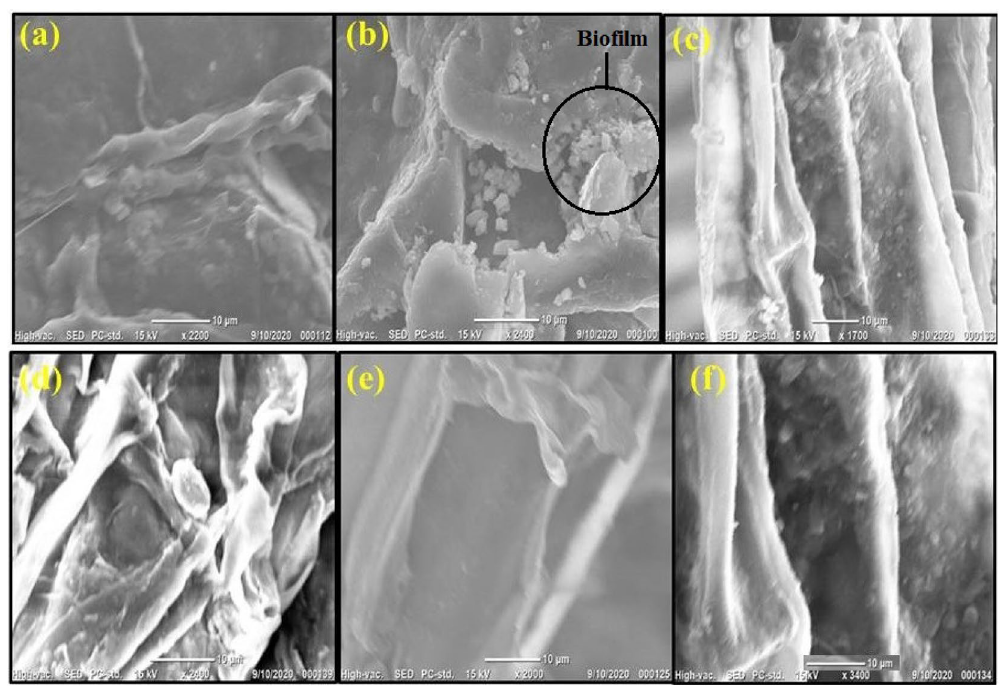
Figure 6. Screening Electron Microscopic observations visualizing biofilm in wheat root hairs treated with five different bacterial stains. Biofilms were observed after 15 days of drought stress induction. Here, ( a ), ( b ), ( c ), ( d ), ( e ), and ( f ) indicate control, Bp, Bm, Sm, As, and Bt inoculations,